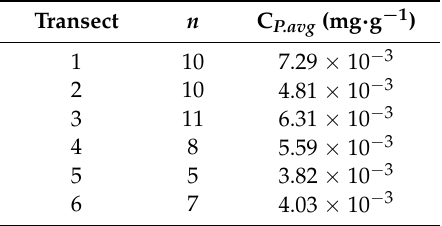
Table 3. Longitudinal variation in average surface Fr.W P concentrations, with the samples presented as transects with transect 1 being the most upstream.